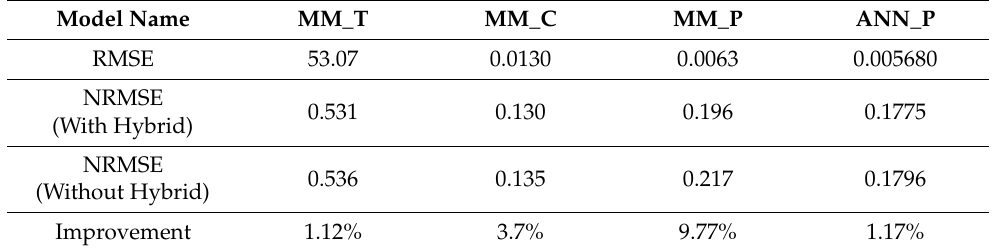
Table 9. Comparison of model evaluations of the hybrid models and non-hybrid